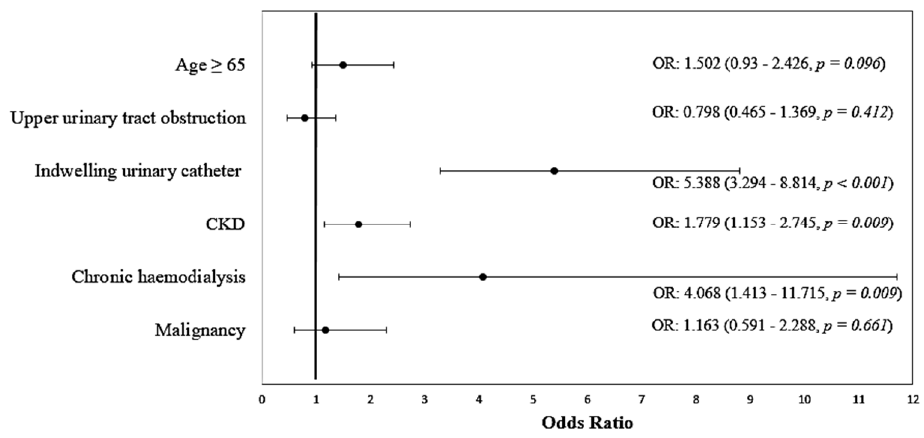
Figure 4. Forest plot for odds ratio with 95% confidence intervals–multivariate analysis of risk factors for multi-drug antimicrobial resistance.